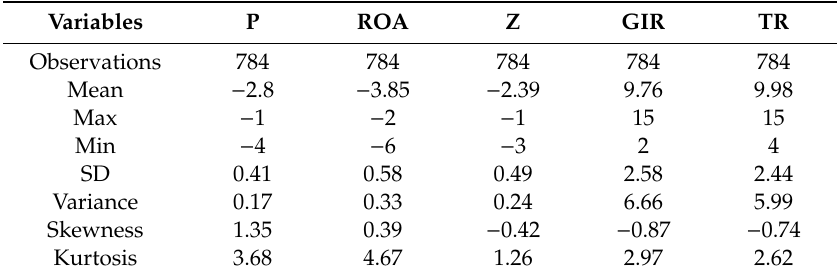
Table A1. Descriptive statistics for dependent variable.